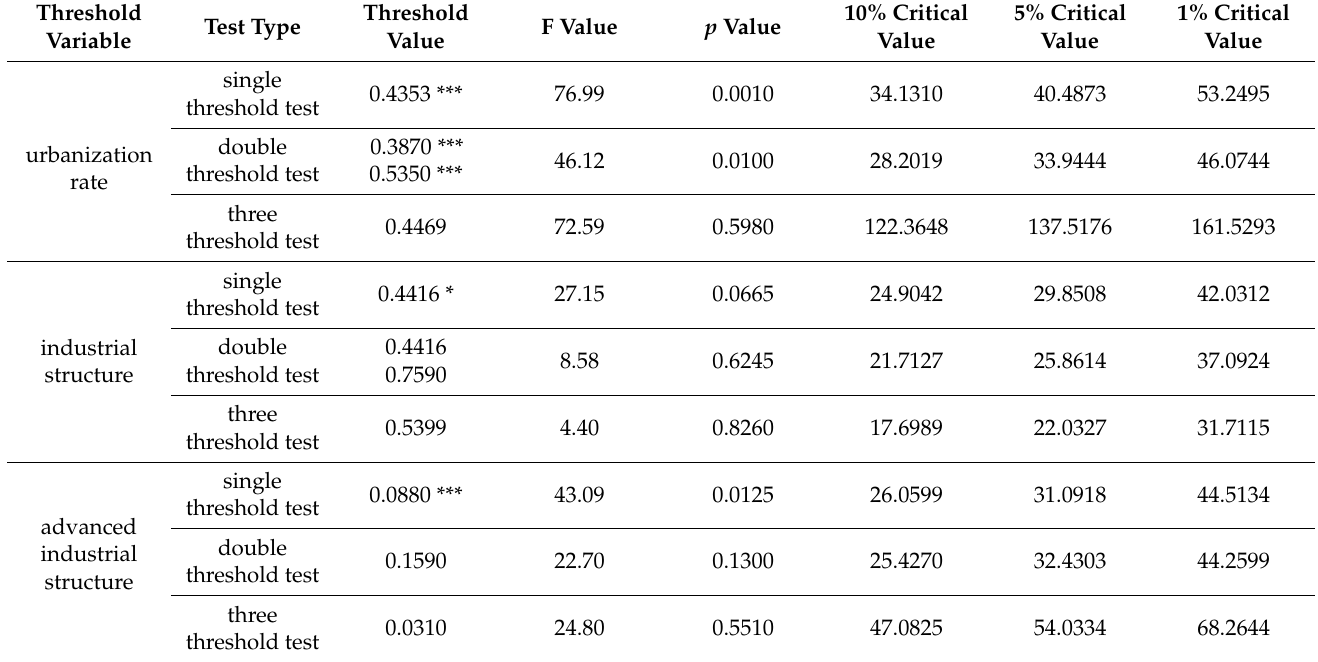
Table 9. Test of the threshold effect of transportation land transfer on economic growth.